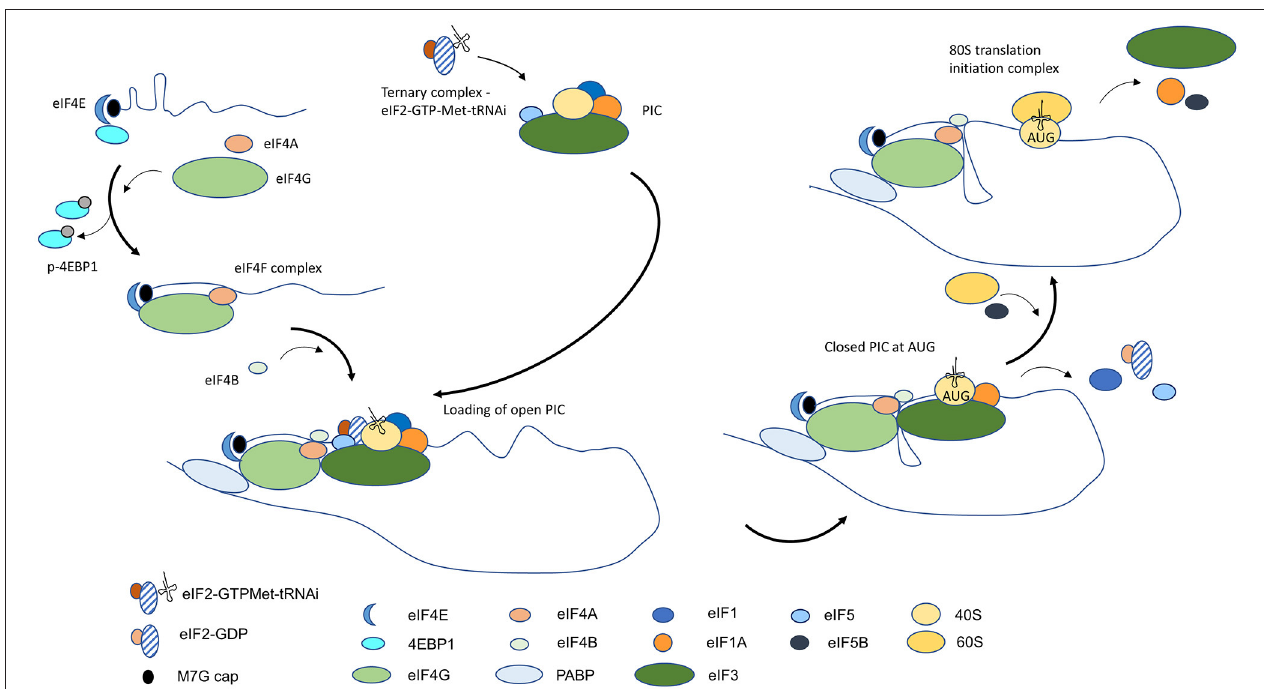
FIGURE 1 | Diagrammatic overview of conventional cap-dependent translation initiation in eukaryotic cells. Translation initiation begins with the assembly of the ternary complex and PIC and binding of 5 ′ mRNA cap by the eIF4F complex. Unwinding of mRNA near the cap by eIF4F facilitates loading of the open state PIC that is conducive to scanning. A conformational change to a closed state occurs on recognition of the start AUG, and with the entry of 60S ribosomal subunit and the formation of the 80S translation initiation complex, protein synthesis